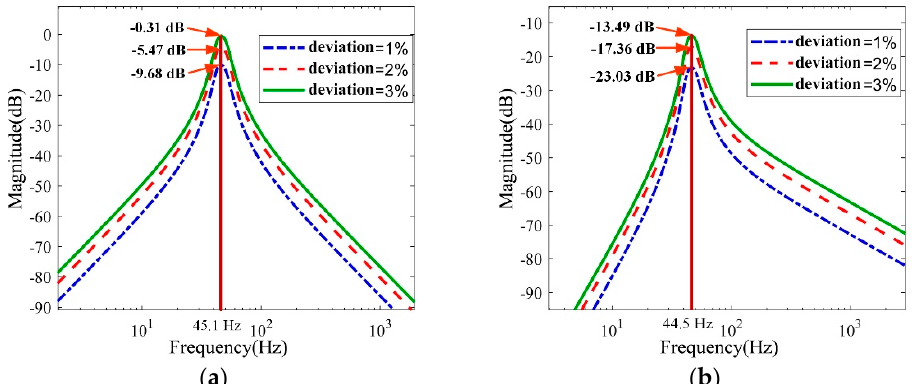
Figure 5. Amplitude-frequency curves of transfer functions with different parameter deviations. ( a ) Different stiffness deviations; ( b ) Different damping deviations.